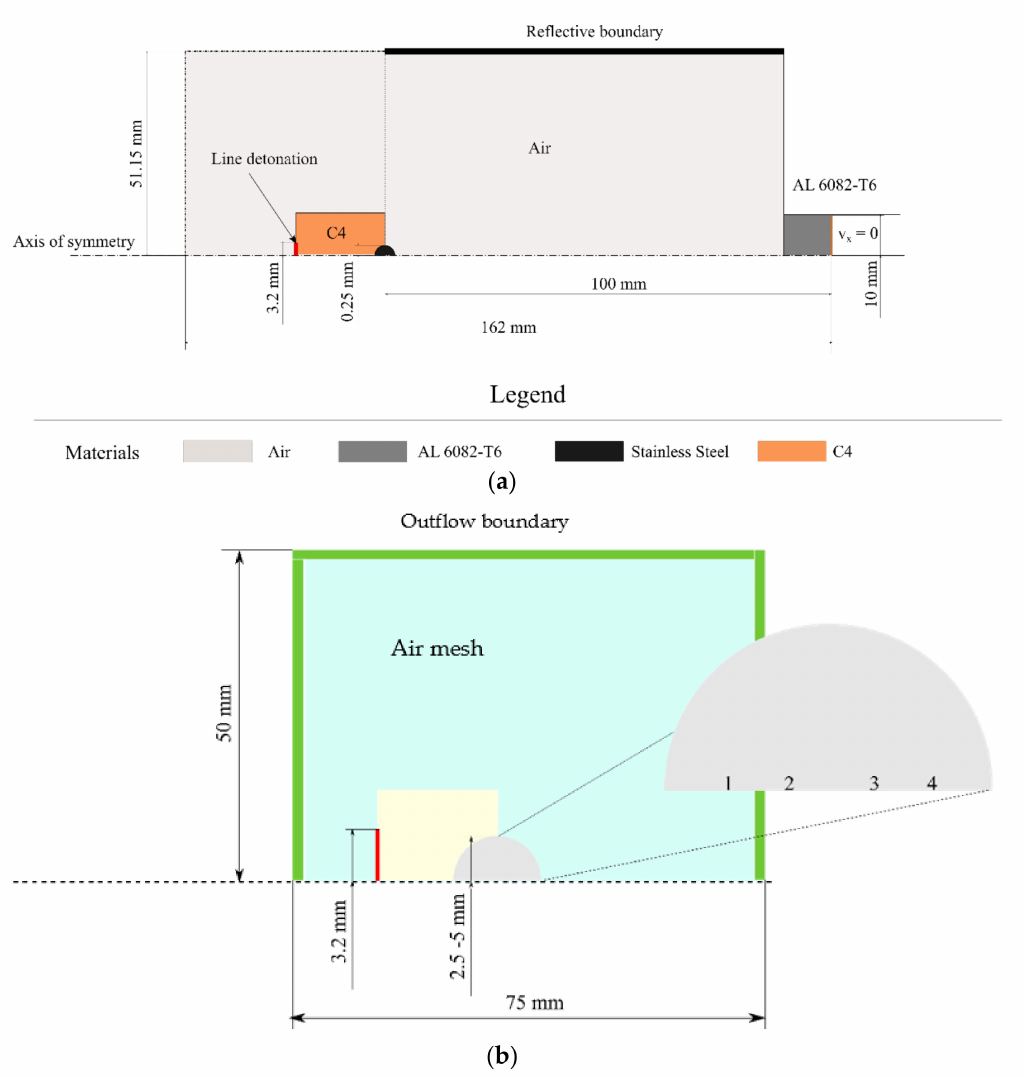
Figure 4. Schematic showing the geometry and boundary conditions used in ( a ) the velocity simula- tions and ( b ) the ball bearing simulations with an inset to represent the approximate locations of the four gauges used in the hydrostatic pressure